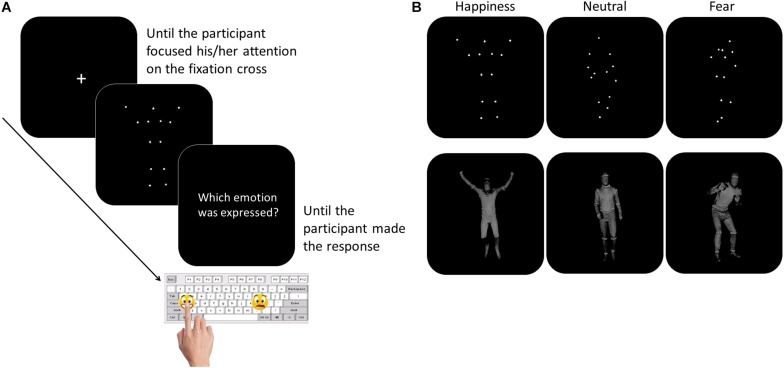
Participants performed a two forced-choice non-verbal task, during which they were asked to recognize the emotion content of whole- BMs by pressing the corresponding emoticon on the keyboard (Panel A). The stimuli included happy, neutral, or fearful body movements depicted as PLDs (Panel B, top row) and FLDs (Panel B, bottom row).